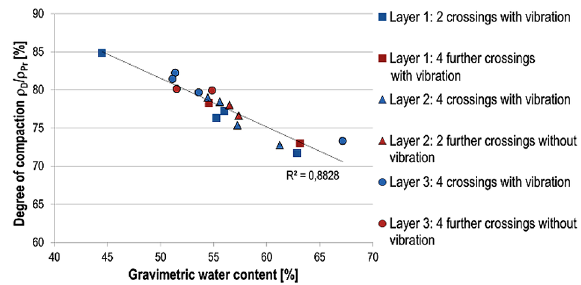
Fig. 4. DOC for M2 and different installation and compaction modes with/ without vibration, variation of crossings